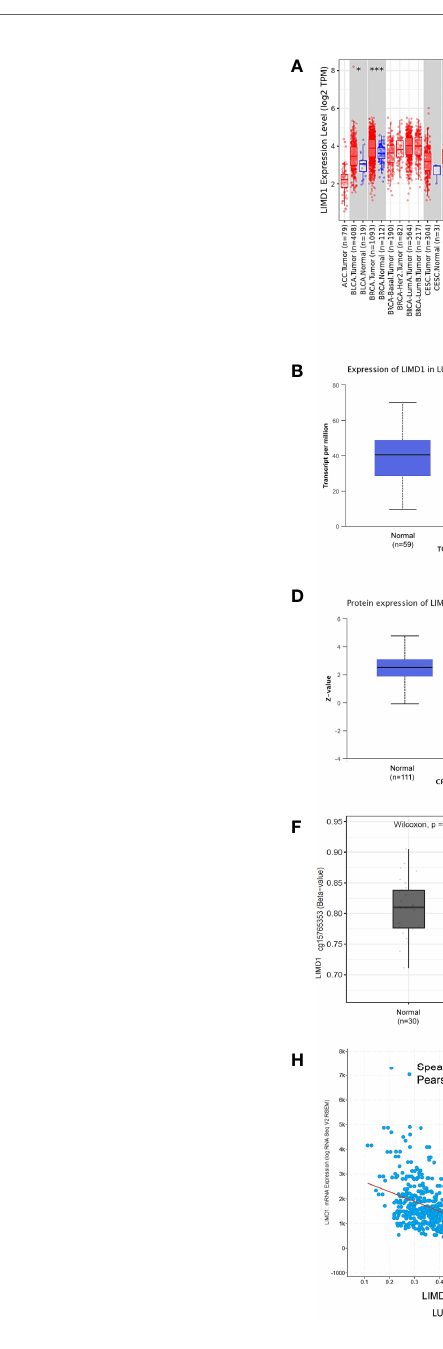
FIGURE 2 | LIMD1 is downregulated in NSCLC. (A) Deregulation of LIMD1 at the transcriptional level in various cancers (*: p < 0.05; **: p<0.01; ***: p<0.001). Blue: Normal tissues; Red: Tumor tissues. Pink: Tumor tissues without normal tissue controls; Purple: Metastasis tumor tissues. ACC: Adrenocortical carcinoma; BLCA: Bladder Urothelial Carcinoma; BRCA: Breast invasive carcinoma; CESC: Cervical squamous cell carcinoma and endocervical adenocarcinoma; CHOL: Cholangiocarcinoma; COAD: Colon adenocarcinoma; DLBC: Diffuse large B-cell lymphoma; ESCA: Esophageal carcinoma; GBM: Glioblastoma multiforme; HNSC: Head and Neck squamous cell carcinoma; KICH: Kidney chromophobe; KIRC: Kidney renal clear cell carcinoma; KIRP: Kidney renal papillary cell carcinoma; LAML: Acute myeloid leukemia; LGG: Brain lower-grade glioma; LIHC: Liver hepatocellular carcinoma; LUAD: Lung adenocarcinoma; LUSC: Lung squamous cell carcinoma; MESO: Mesothelioma; OV: Ovarian serous cystadenocarcinoma; PAAD: Pancreatic adenocarcinoma; PCPG: Pheochromocytoma and paraganglioma; PRAD: Prostate adenocarcinoma; READ: Rectum adenocarcinoma; SARC: Sarcoma; SKCM: Skin cutaneous melanoma; STAD: Stomach adenocarcinoma; TGCT: Testicular germ cell tumors; THCA: Thyroid carcinoma; THYM: Thymoma; UCEC: Uterine corpus endometrial carcinoma; UCS: Uterine carcinosarcoma; UVM: Uveal melanoma. (B, C) LIMD1 transcription is downregulated in LUAD and LUSC, respectively. (D, E) LIMD1 protein level and S233 phosphorylation are downregulated in LUAD. (F, G) LIMD1 promoter is signi fi cantly methylated in both LUAD and LUSC. (H, I) LIMD1 gene transcription negatively correlates with its promoter methylation in LUAD and LUSC, respectively. (A) is the results from the TIMER2 portal, (B, G) from UALCAN, and (H, I) from